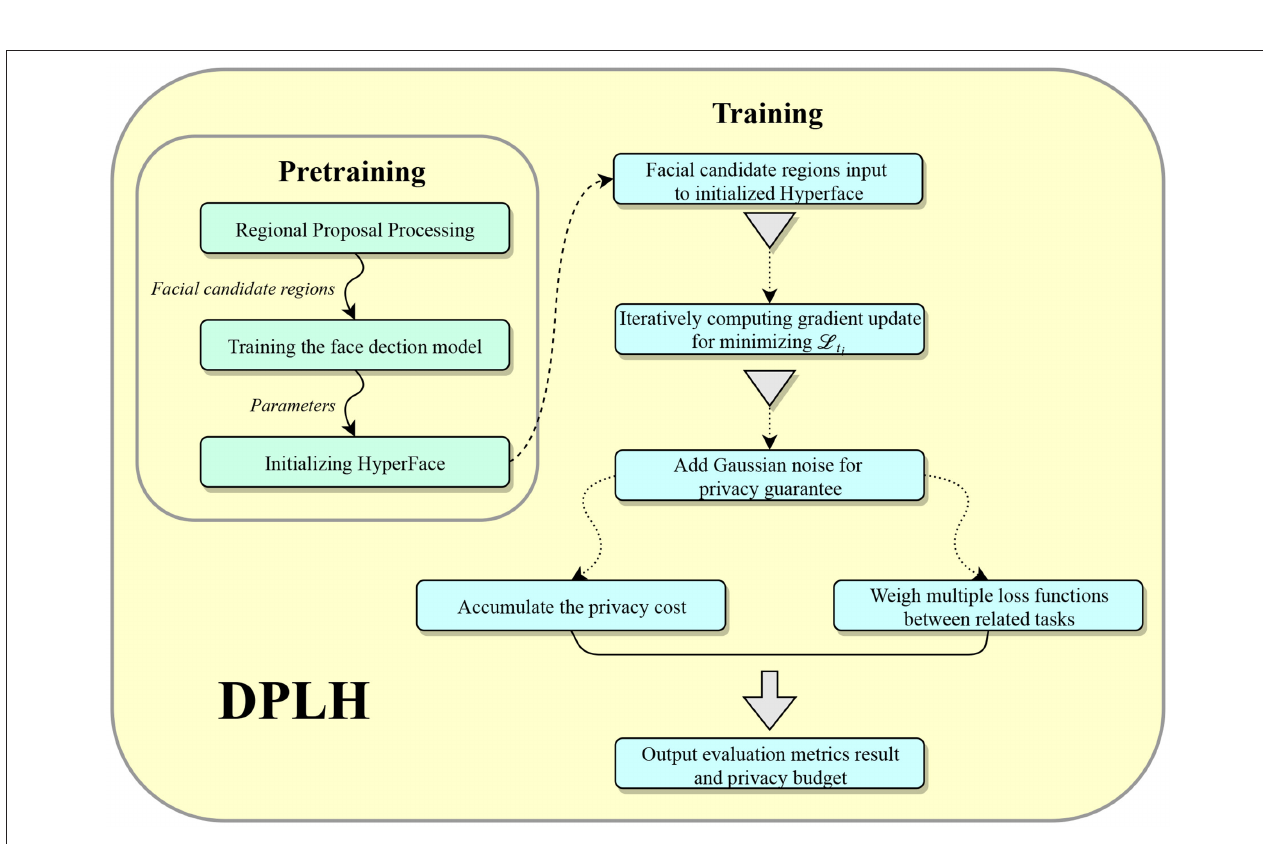
FIGURE 2 | The architecture of